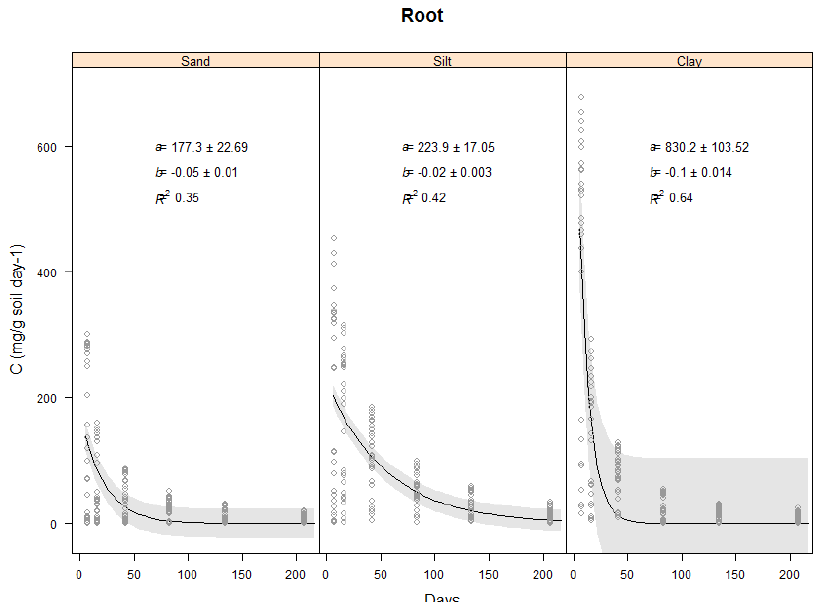
Figure 4. Carbon (mg C g soil − 1 day − 1 ) evolved from blank soils and from the decomposition of the whole vetiver root biomass in three soils during 206 days-incubation period. Where vetiver root biomass used from the glasshouse experiment and incubated at 25 ◦ C constant temperature. Plots show the raw data (o), a fitted exponential model (–) and 95% confidence bands. Values of the intercept (a), the slope (b) and Coefficient of determination (R 2 ).